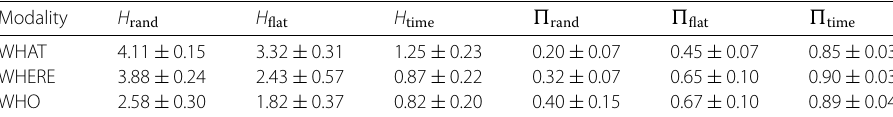
Table 2 Empirical entropy (left) and predictability (right) averaged over all study participants and standard deviation thereof Modality H